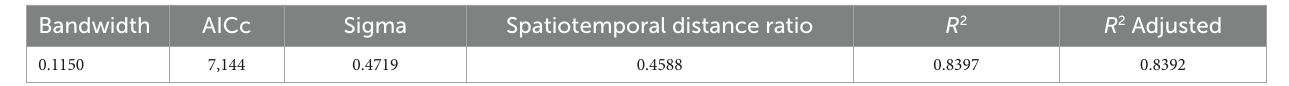
TABLE 2 Result of GTWR model.